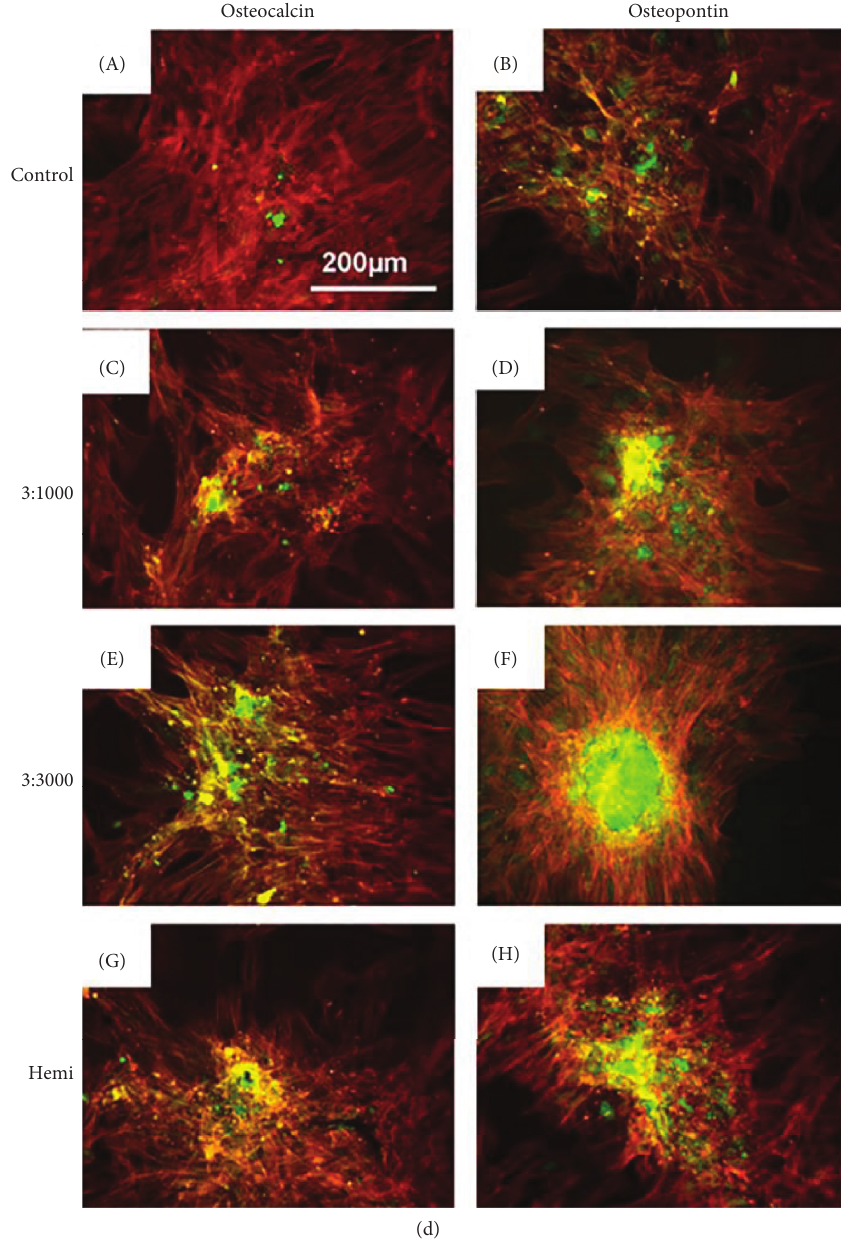
Figure 4: (a) Histochemical staining of calcium phosphate with Alizarin Red S at day 21 after osteogenic differentiation. (b) Immu- nofluorescence staining of type I collagen (Col (I)) in hADSCs at day 21 after osteogenic differentiation in the presence of BM (basal medium; upper panel) and OM (osteogenic differentiation medium; lower panel) [137] (Copyright 2016, Elsevier). (c) Immunofluorescence and western blotting analysis of osteogenic marker protein in BMSCs cocultured with different scaffolds [139] (Copyright 2017, Royal Society of Chemistry). (d) Osteocalcin (OC) and osteopontin (OPN) fluorescent images for hMSCs cultured on the control and test materials [144] (Copyright 2006,